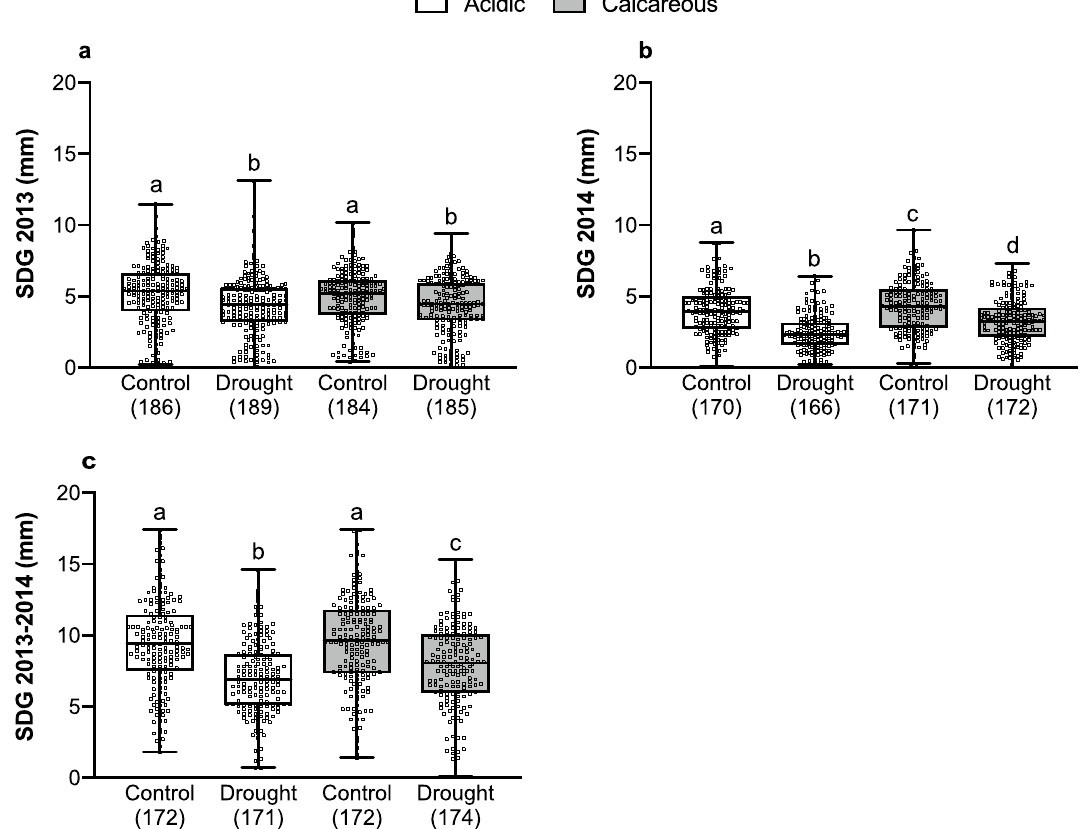
Figure 2. Stem diameter growth (SDG) measured in 2013 ( a ), 2014 ( b ), and 2013–2014 ( c ) in the control and drought treated saplings from acidic and calcareous soils. Different letters (a, b, c, and d) above whiskers indicate significant differences ( P < 0.05). Box plots present median, upper, and lower quartiles; whiskers show minimum and maximum values. Sample size is presented in parentheses.